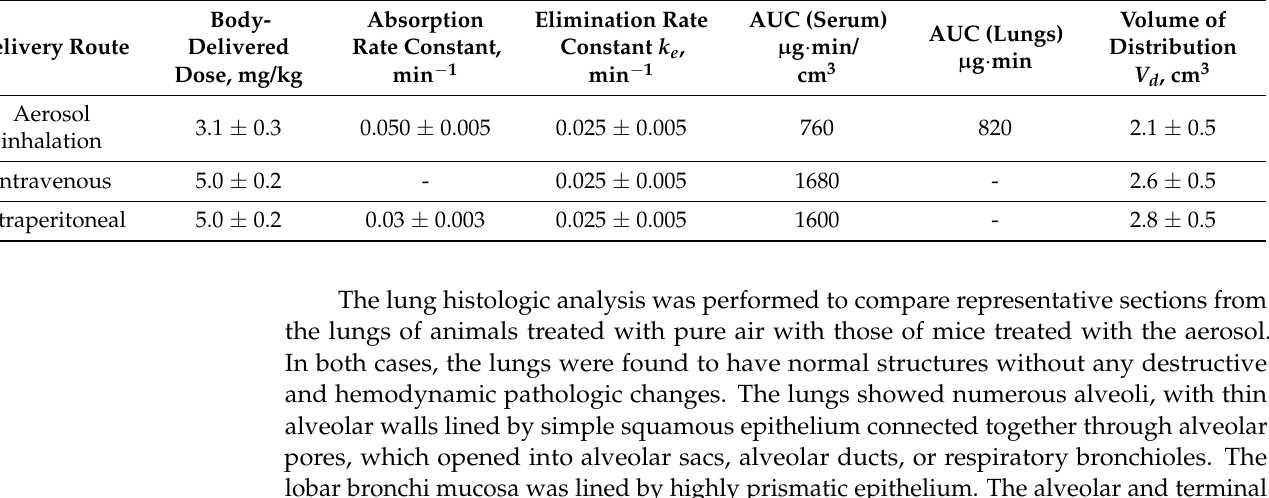
Table 2. Comparison of pharmacokinetic parameters determined for different routes of drug